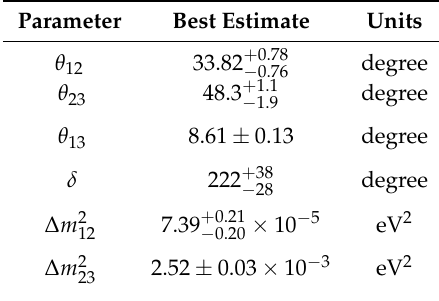
Table 1. Current value of the mass and mixing parameters as extracted from neutrino oscillation data under the hypothesis of normal hierarchy (current best fit)